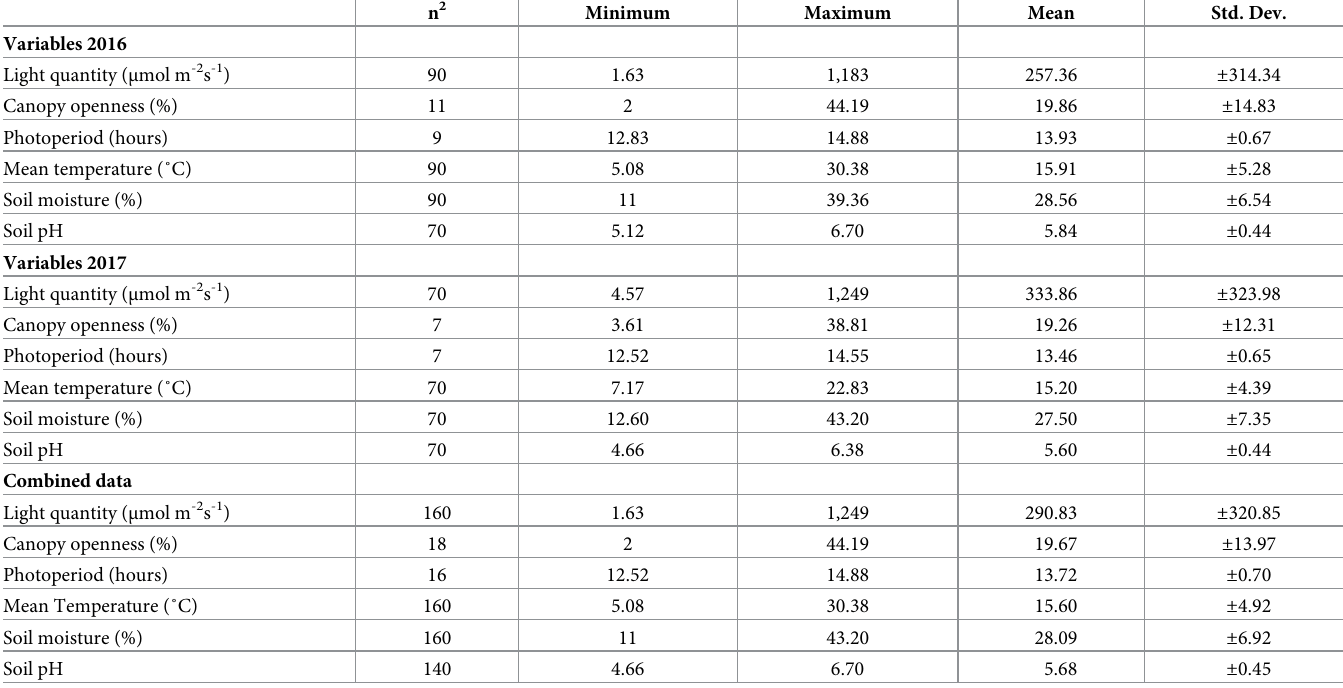
Table 1. Environmental variables measured over a native V . pubescens population (n 1 = 10 plots) during spring and summer of 2016 and 2017 in Sells Park, Athens County, Ohio. Environmental variables were averaged † prior to calculating summary statistics. n